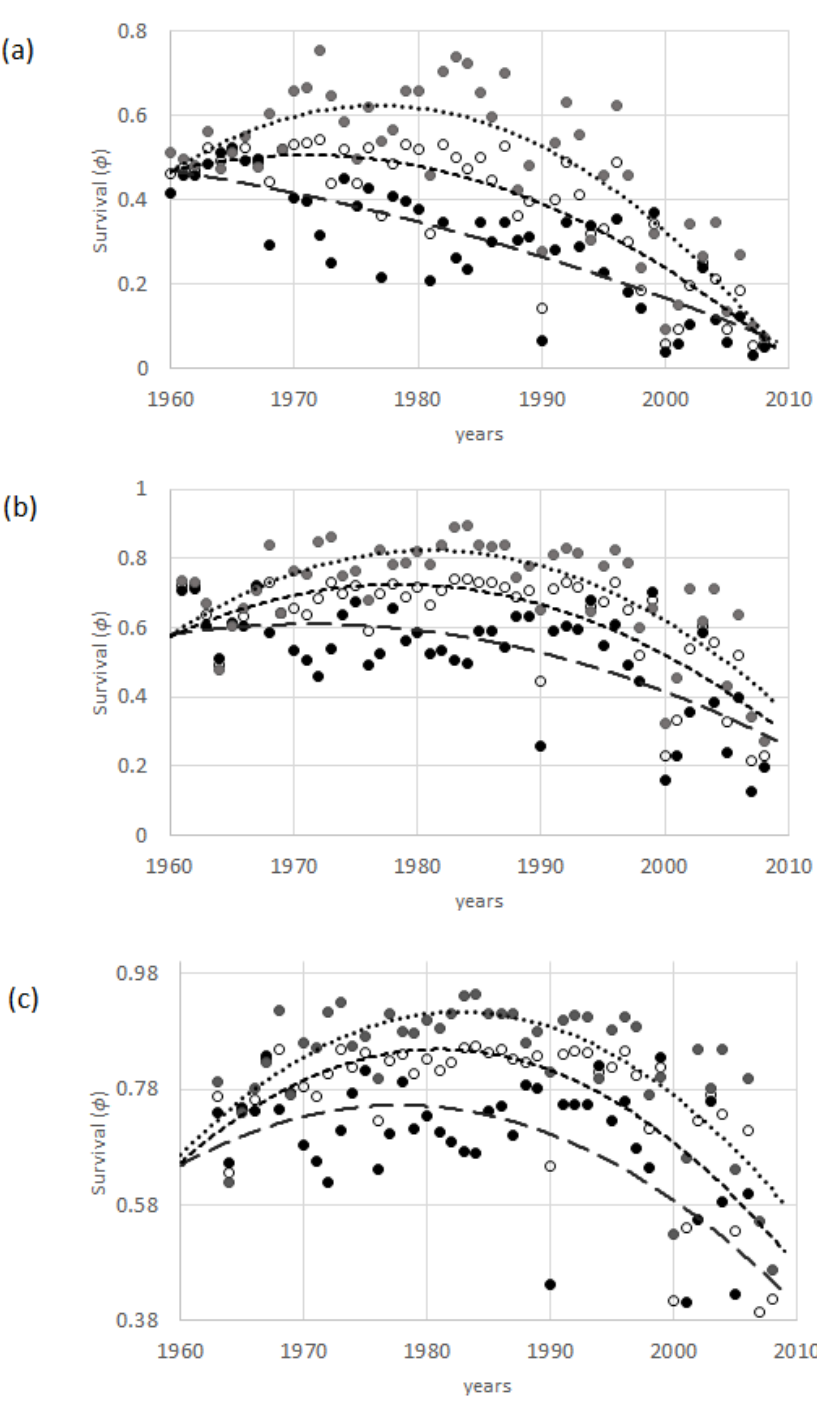
Figure 2. Age-specific survival rates ( φ ) across main geographical regions over the study period. ( a ): Juveniles; ( b ): Immatures; ( c ): Adults in different latitudinal regions: South (dark dots): 40 ◦ ; Centre (white dots): 46 ◦ ; North (grey dots): 52 ◦ . Temporal trends (second-order polynomial) in the age-survival probabilities. Survival estimates were derived from the best fit model (lower QAICc) in Table 2, where survival of all age classes was time-constrained by the quadratic Northern temperature anomaly and linearly constrained by the Sahel index (additive effect). The model also included an additive effect on the survival of the covariates (latitude, trend in NDVI, mean distance to dump) and interaction terms between covariates and latitude. The model also included three age classes for recapture probabilities. Recapture rates were dependent on latitude in the ringing site and followed an exponential temporal trend (additive effect). Estimates were based on average values of the individual